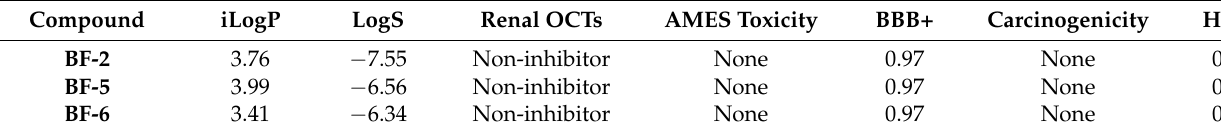
Table 6. ADME&T profile of bromobenzofuran-oxadiazoles BF-2 , BF-5 and BF-6 .